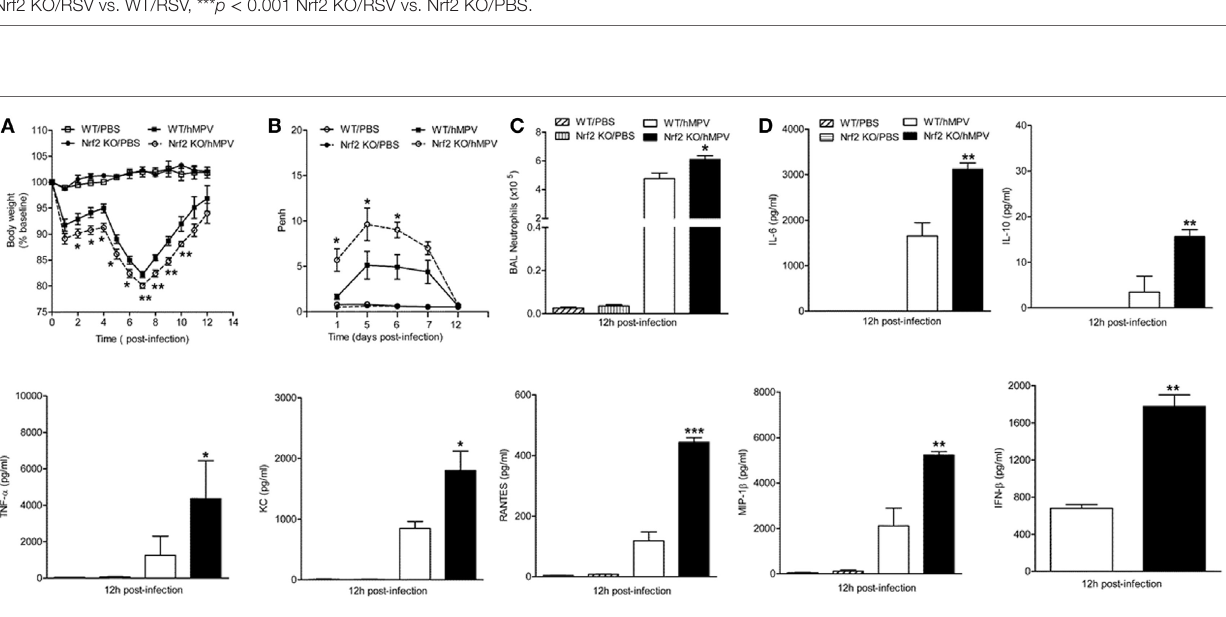
FigUre 8 | NF-E2-related factor 2 (Nrf2)-deficient mice have greater clinical disease, airway obstruction, bronchoalveolar lavage (BAL) neutrophilia, and cytokine production following infection with human metapneumovirus (hMPV). Nrf2 KO and Nrf2 WT mice were infected with hMPV or PBS. (a) Mice were monitored daily for changes in body weight. (B) Airway obstruction was assessed by unrestrained plethysmography as baseline Penh. (c) Total number of neutrophils was determined by cytospin analysis of BAL samples collected at 12 h p.i. (D) hMPV alters cytokine/chemokine production in Nrf2-deficient mice. BAL samples were collected at 12 h p.i. from each group of mice and assessed for cytokine/chemokine production by Bio-Plex and type I interferon by enzyme-linked immunosorbent assays. Data are expressed as mean ± SEM ( n = 2–4 mice/group). * p < 0.05, ** p < 0.01, *** p < 0.001 when compared with WT/hMPV.